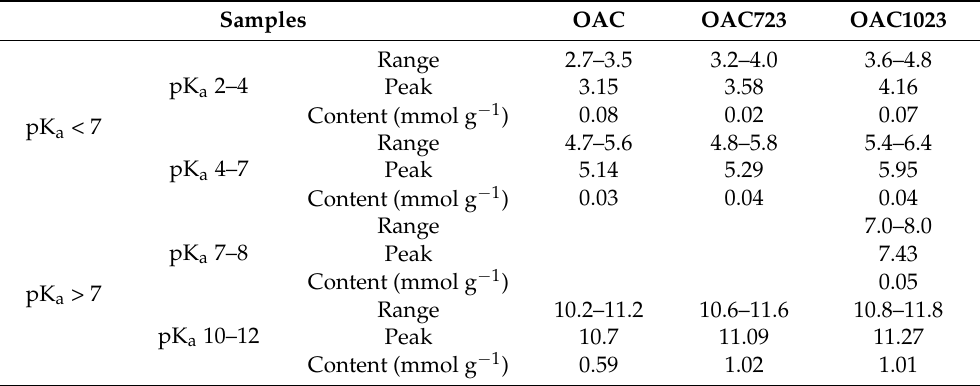
Table 2. Ranges and peaks of the pK a distributions of the activated carbons and their content in mmol g − 1